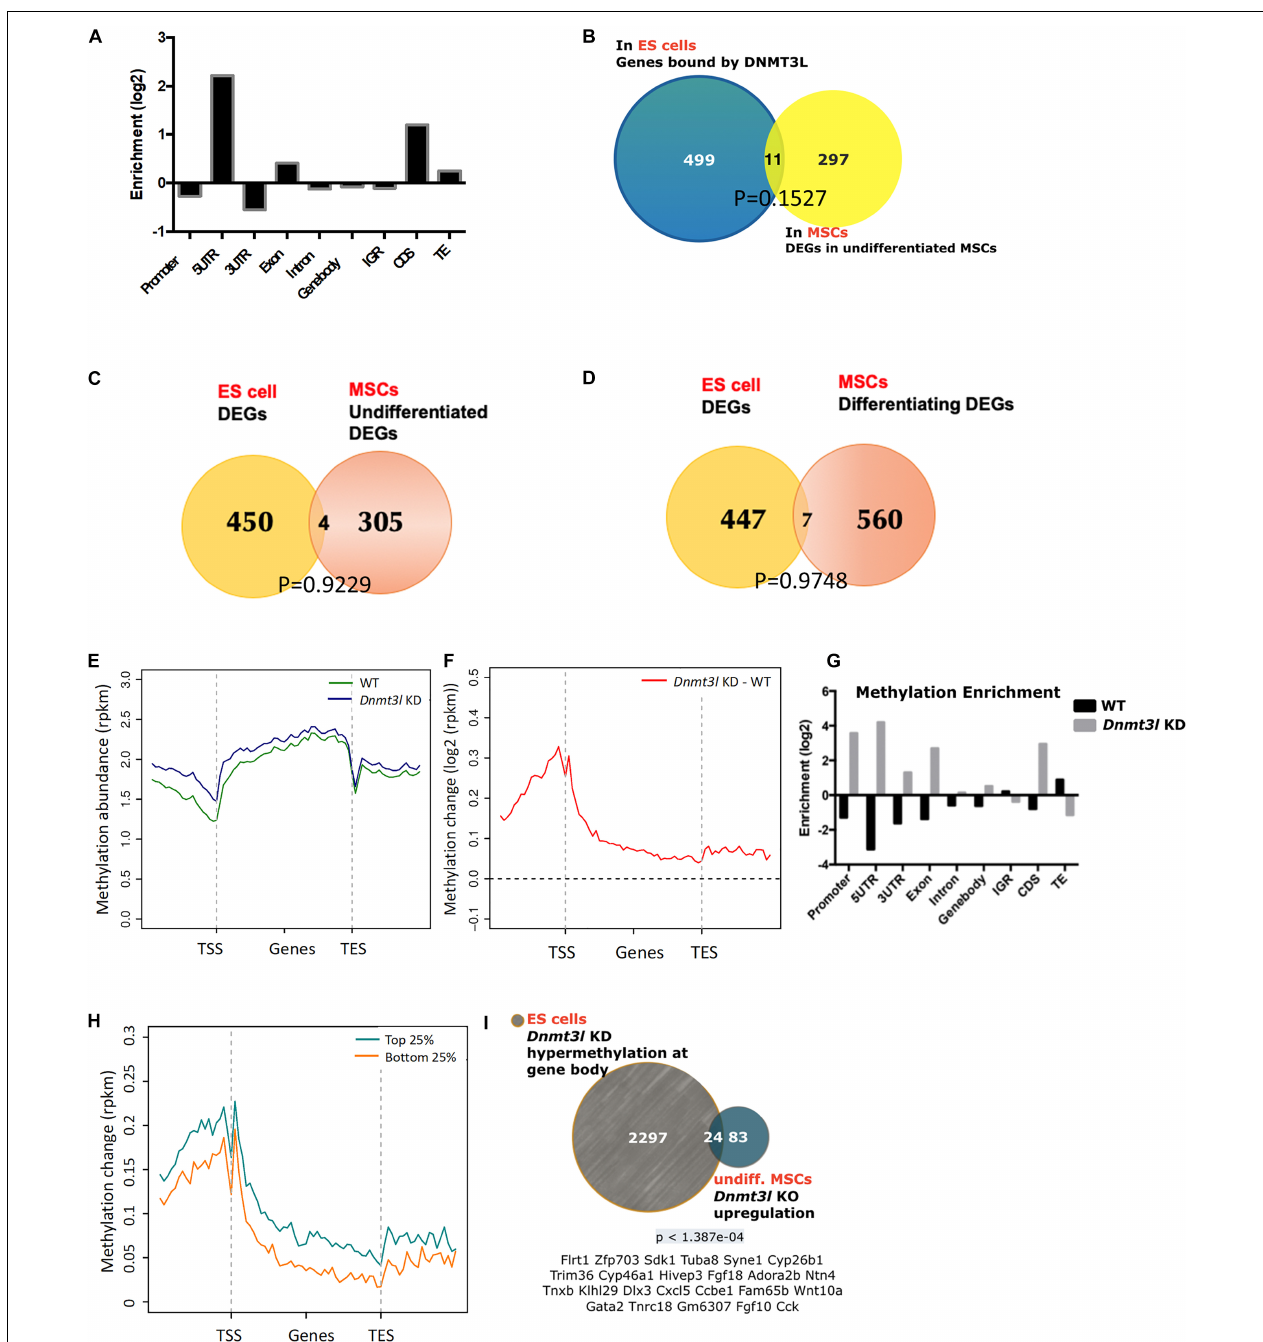
FIGURE 4 | Possibility of DNMT3L-mediated legacy and the DNA methylation level contributing to the compromised self-renewal and differentiation potential of Dnmt3l KO MSCs. (A) Enriched DNMT3L binding in ES cells is observed in the 5 (cid:48) UTR and coding region of coding genes. (B) Only 11 out of 308 DEGs between undifferentiated MSCs derived from WT and Dnmt3l KO mice are direct DNMT3L binding targets in ES cells. (C) Only four genes are differentially expressed in both ES cells and undifferentiated MSCs between the WT and Dnmt3l mutant cells ( Dnmt3l KO MSCs and Dnmt3l KD ESCs); (D) Only seven genes are differentially expressed in both ES cells and differentiating MSCs between WT and Dnmt3l mutants. (E) DNA methylation level in WT and Dnmt3l KD ES cells are profiled for all genes as well as their immediate upstream and downstream regions. (F) The methylation regions in Dnmt3l KD ES cells are enriched in the 5 (cid:48) UTR and coding sequence. (G) Differential gene methylation between WT and Dnmt3l KD ES cells. Greater enrichment on TEs in WT ES cells are observed, indicating that DNMT3L facilitates de novo methylation in these sequences. (H) The difference in gene methylation between WT and Dnmt3l KD in high/low expression genes. (I) Twenty-four out of 107 genes upregulated in Dnmt3l KO MSCs are overlapped with hypermethylated genes in ES cells with Dnmt3l knock down. The p -value calculated by hypergeometric test is very low, indicating that these 24 up-regulated genes in Dnmt3l KO MSCs are not due to random overlapping in highly methylated ES cells.